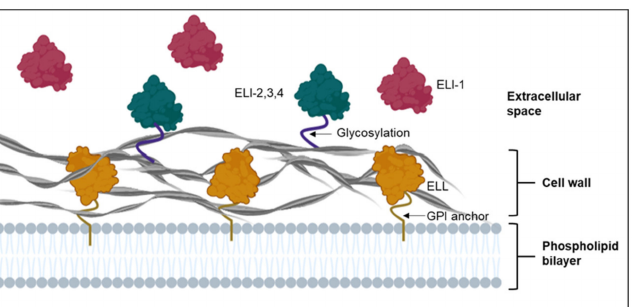
Figure 1. Characterization of elicitins and elicitin-like proteins based on their localization. Class I elic- itins (ELI-1) (represented in red) such as cryptogein, which is produced by Phytophthora cryptogea [20], are released into the extracellular space. Class II, III and IV elicitins (ELI-2, -3 and -4) (represented in green), such as inf2A produced by P. infestans [23], are hypothesized to be linked to the cell wall by glycosylation of the C-terminal domain. Other elicitin-like (ELL) proteins (represented in orange) are postulated to be attached to the cell membrane with a glycosylphosphatidylinositol (GPI)